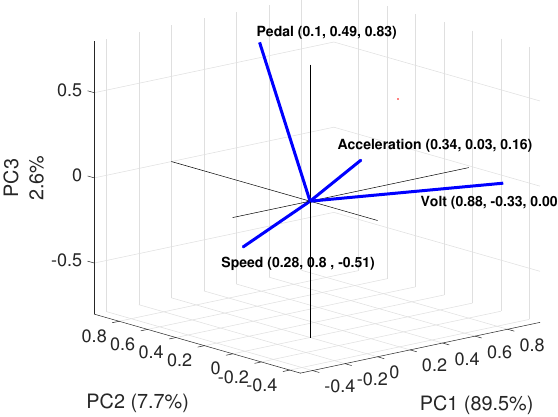
Figure 2. Input variable vector representation in the principal components’